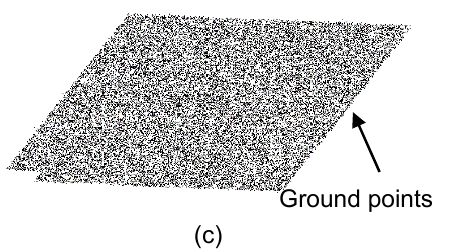
Figure 6. ( a ) The simulated point cloud before denoising, ( b ) denoised result by spherical detection (relevant factors refer to No. 4 in Table 2) and ( c ) denoised result by ellipsoid detection (relevant factors refer to No. 3 in Table 2).